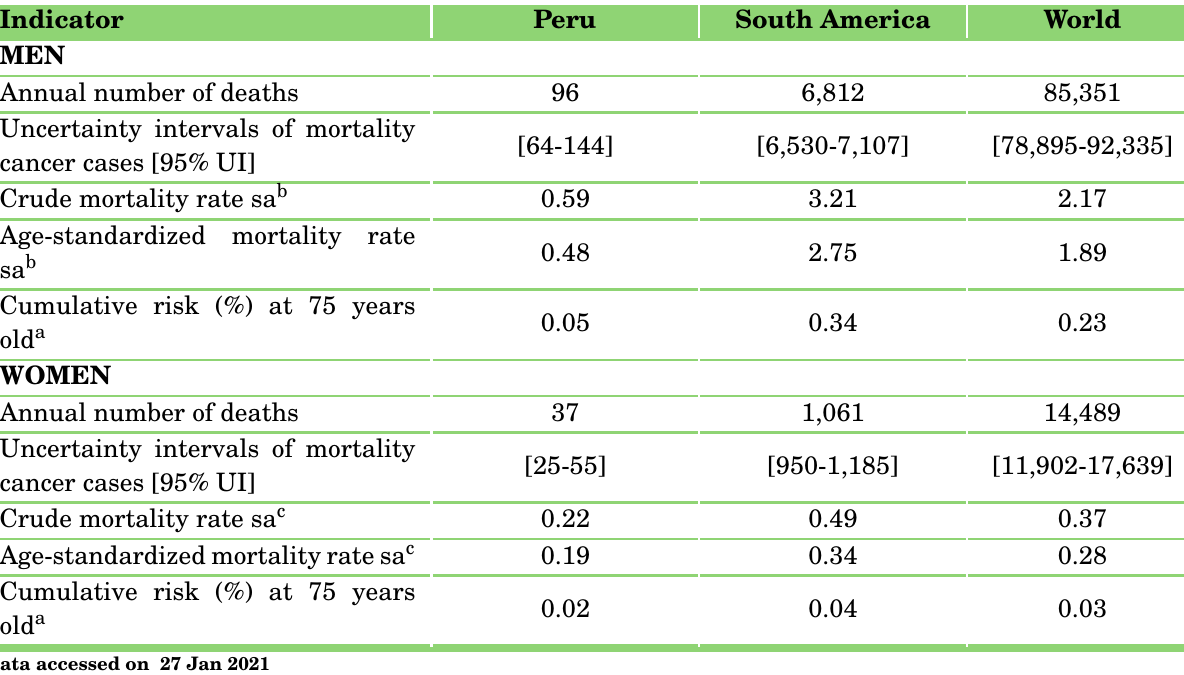
Table 20: Laryngeal cancer mortality in Peru (estimates for 2020) Indicator Peru South America World